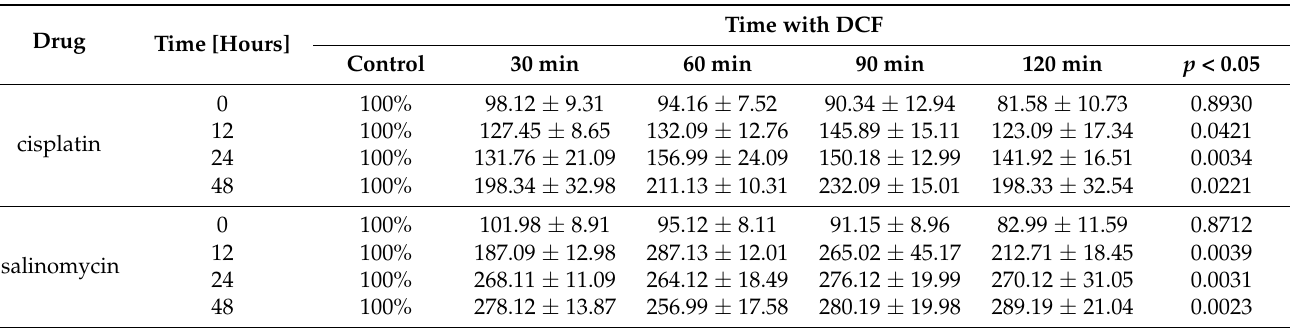
Table 1. Changes in DCF fluorescence in Ishikawa cultures exposed to cisplatin or salinomycin compared to untreated